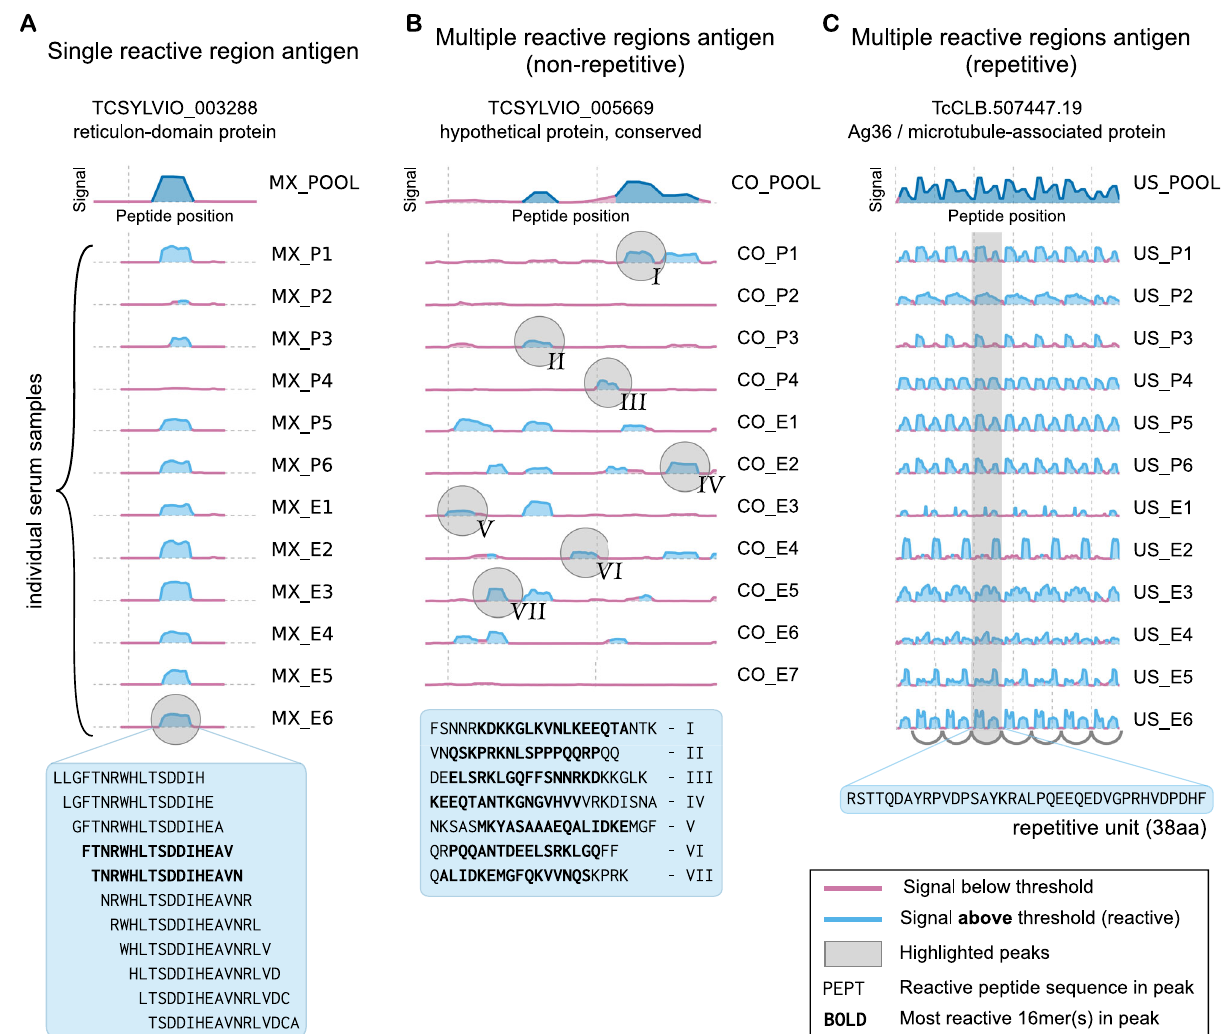
Fig. 4 | Individual patient resolution and epitope mapping of Chagas disease antigens. Examples of different types of antibody-binding pro fi les obtained using CHAGASTOPE-v2 arrays. In all cases, the reactivity of the pooled samples in the CHAGASTOPE-v1 discovery screening is shown at the top (dark blue), and stacked plots of the reactivity of the same protein against individual serum samples are shown below. See Supplementary Data S2 for the codes of patient serum samples (MX=Mexico, CO=Colombia, US=United States). Source data are provided as a